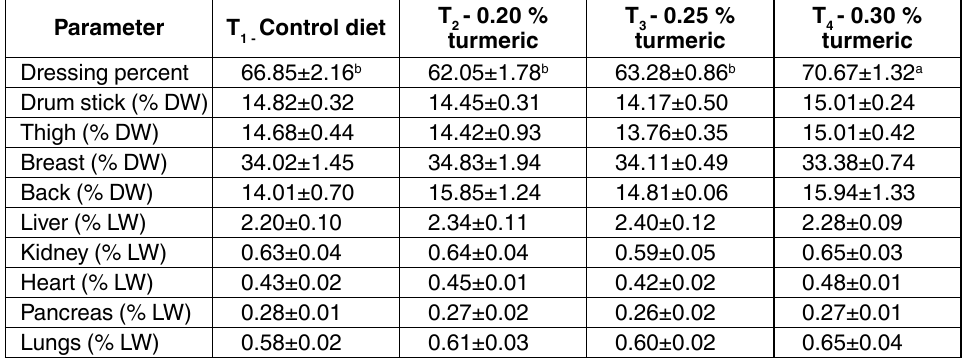
Table 4. Effect of turmeric powder on carcass characteristic of broiler